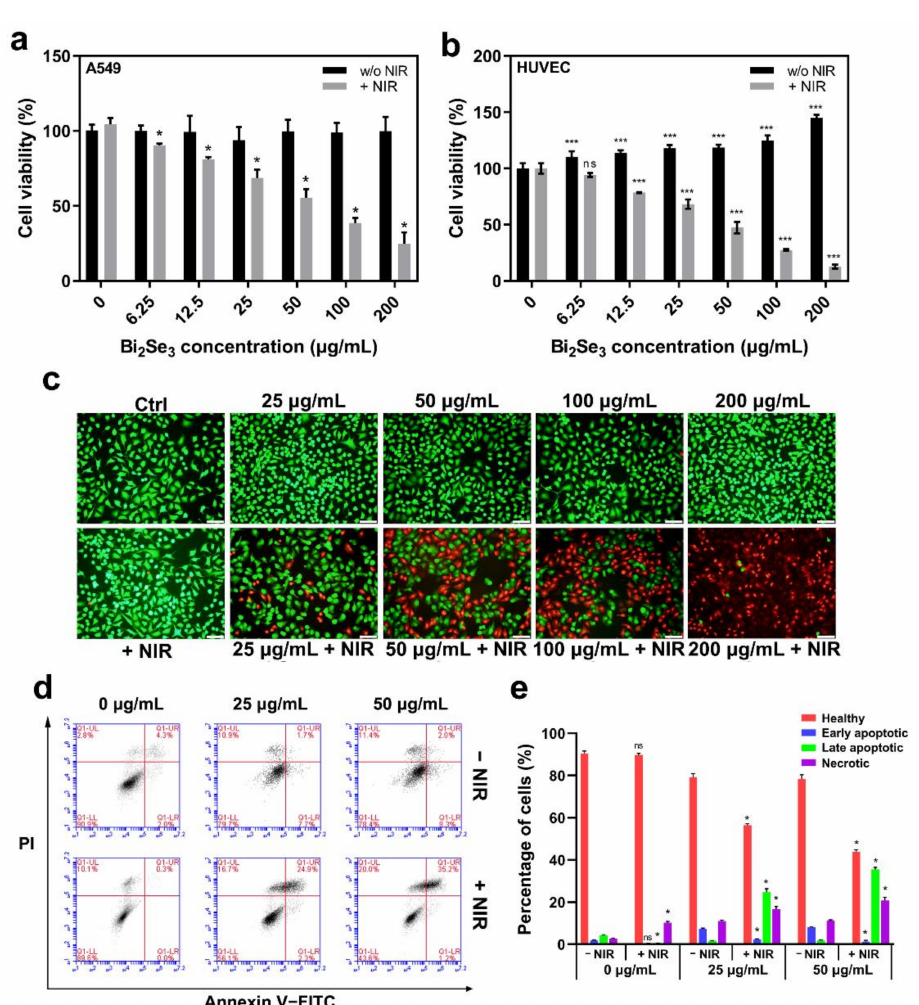
Figure 3. Photothermal killing of A549 cells by Bi 2 Se 3 particles. The viability of A549 cells ( a ) and HUVEC cells ( b ) upon Bi 2 Se 3 exposure (0, 6.25, 12.5, 25, 50, 100, 200 µ g/mL) with or without laser irradiation. * p < 0.05, *** p < 0.01, versus untreated control group; ( c ) Live–dead staining of A549 cells. A549 cells were incubated with Bi 2 Se 3 with or without laser irradiation. Cells with green fluorescence (calcein-positive cells) represent live cells while red fluorescence dead cells (PI- positive cells). Scale bar: 40 µ m. The demonstrated images are representative of three independent experiments; ( d ) Apoptosis analysis by flow cytometry using Annexin V-FITC/PI staining kit. Cells were incubated with Bi 2 Se 3 (0, 25, 50 µ g/mL) and subjected to laser irradiation for 10 min followed by a further incubation of 12 h. Then, cells were harvested for apoptosis analysis with annexin V-FITC/PI staining. Representative flow cytometry data were presented; ( e ) The percentages of healthy, early apoptotic, late apoptotic and necrotic apoptotic cells in each group from the results of three independent experiments were quantified (* p < 0.05, versus without NIR